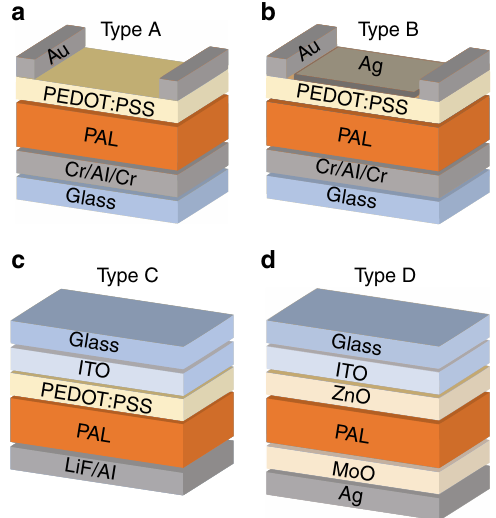
Fig. 1 Schematic illustration of device architectures of the used organic solar cells. Layer stacks of an optically inverted OSC ( a , b ) with additional semitransparent Ag layer. The ITO-based architecture using PEDOT:PSS and LiF/Al electrodes is shown in c and inverted ITO-based architecture using ZnO and MoO 3 as charge selective layers in d